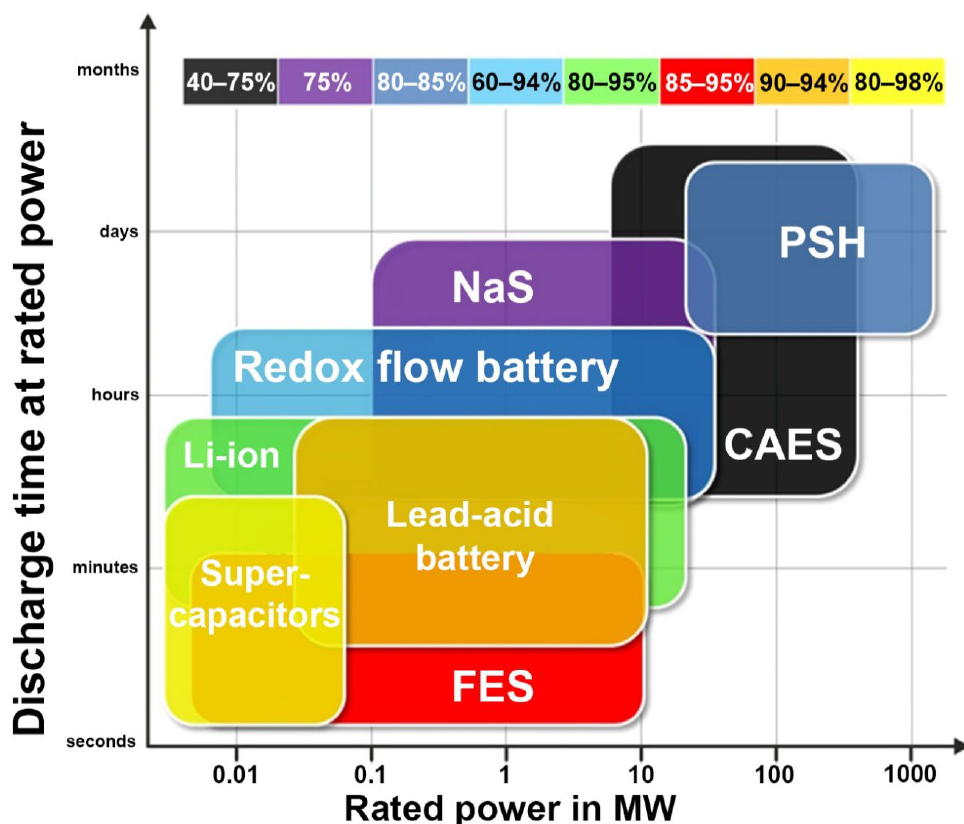
Figure 1. Comparison of different energy storage technologies based on rated power and discharge time [1 3 ].